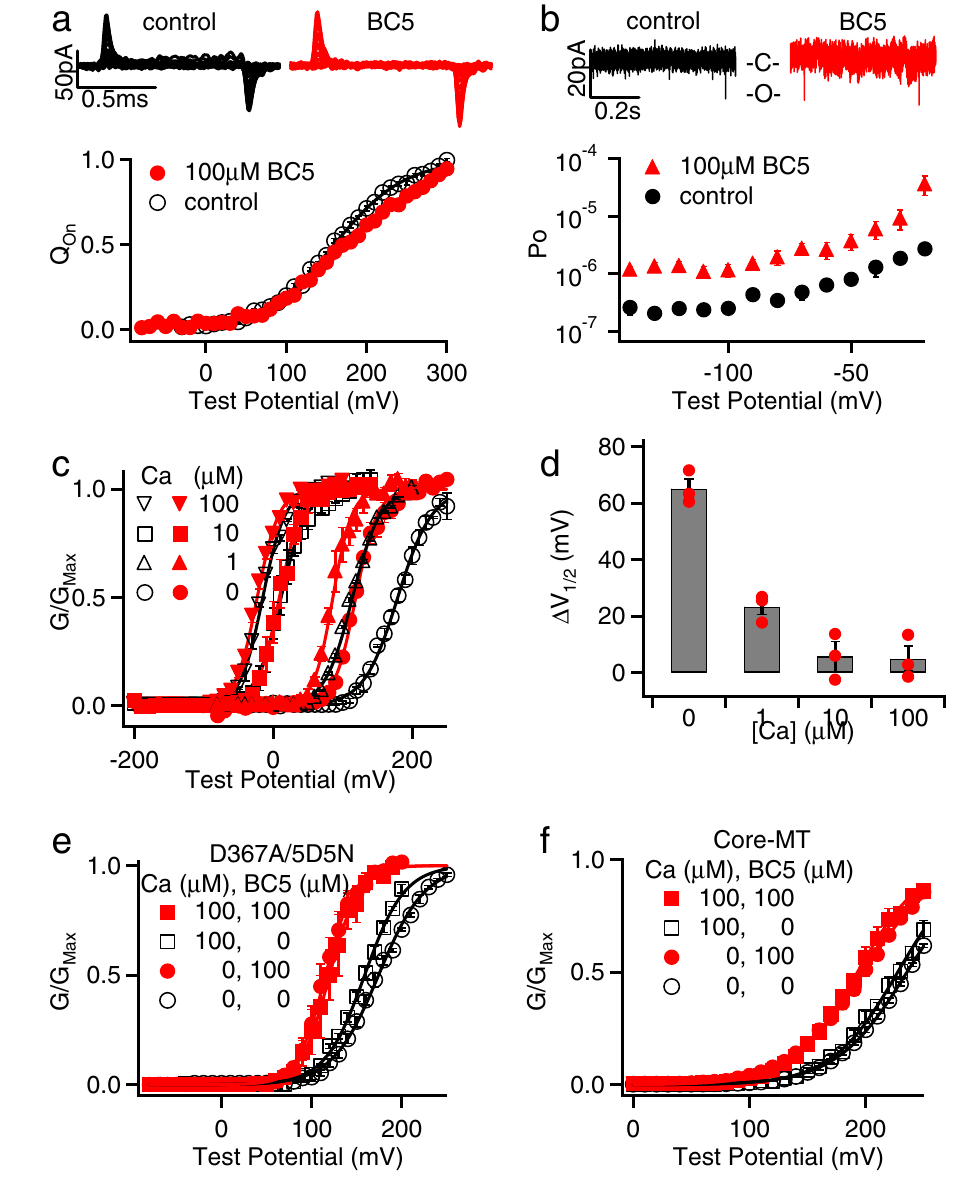
n =3 for all conditions. d GV shifts in response to 100 µ M BC5 at different [Ca 2+ ] Data points are shown in solid circles, all of n =3. e BC5 effects on the D367A5D5N mutant channel in0 and 100 µ M [Ca 2+ ] i . n =4 for0 [Ca 2+ ] i control; n =5 for 0 [Ca 2+ ] i with 100 µ M BC5; n =4 for 100 µ M [Ca 2+ ] i control and n =3 for 100 µ M [Ca 2+ ] i with 100 µ M BC5. D367A and 5D5N (D897-901N) ablated the two Ca 2+ -binding sites in each Slo1 subunit, respectively. GV relations were fi t with the Boltzmann function (solidlines). f BC5effectsontheCore-MTBKchannelin0and100 µ M[Ca 2+ ] i . n =14 for 0 [Ca 2+ ] i control; n =9 for 0 [Ca 2+ ] i with 100 µ M BC5; n =3 for 100 µ M [Ca 2+ ] i control and n =6 for 100 µ M [Ca 2+ ] i with 100 µ M BC5. GV relations were fi t with the Boltzmann function (solid